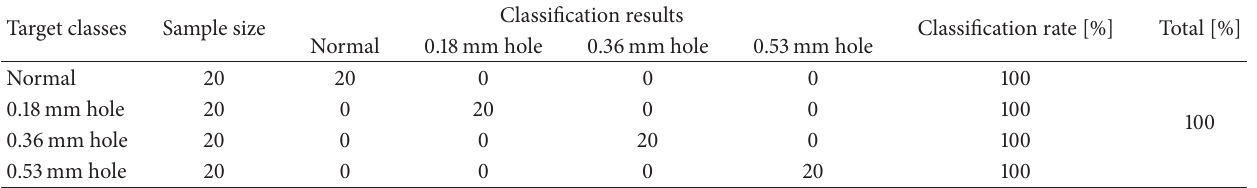
Table 3: Classification results of rolling bearing faults under different severity levels.